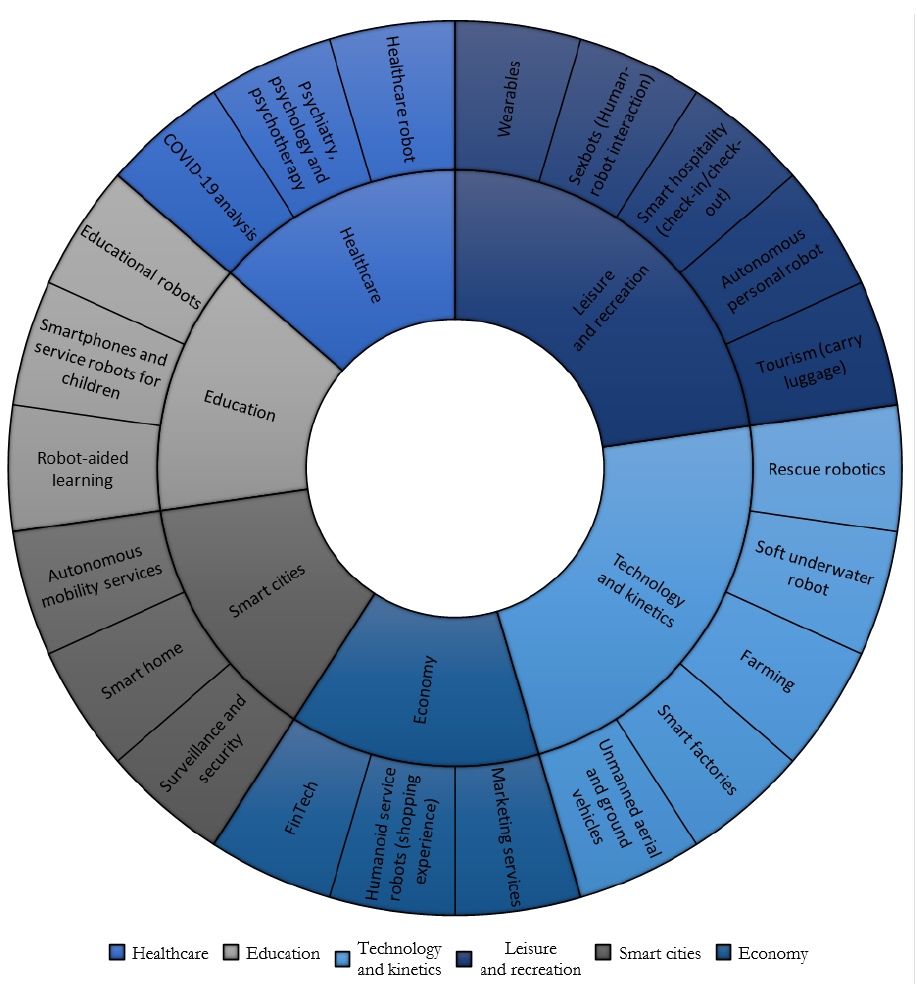
Figure 5. Uses and applications of service robots in different operation